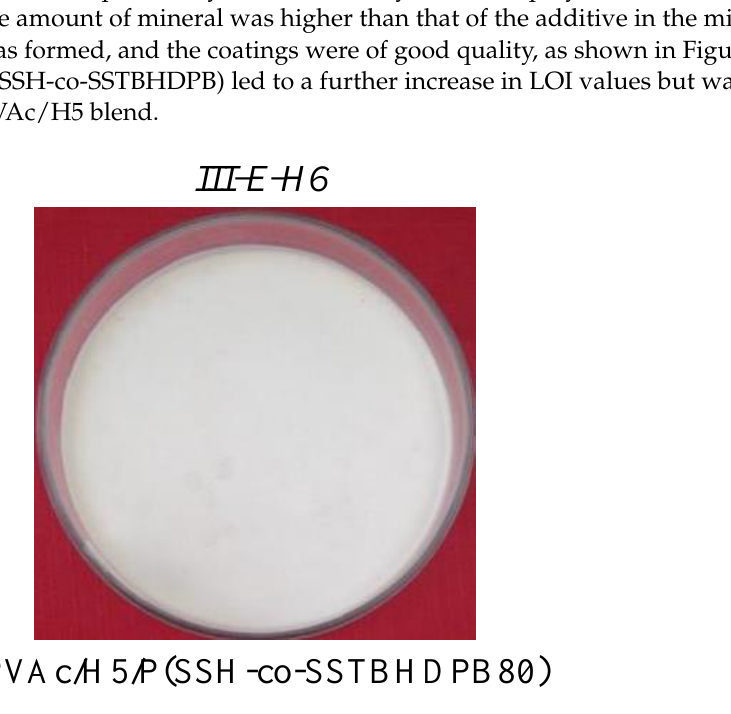
Table 7. LOI measurements of PVAc blends with H5 and additives.